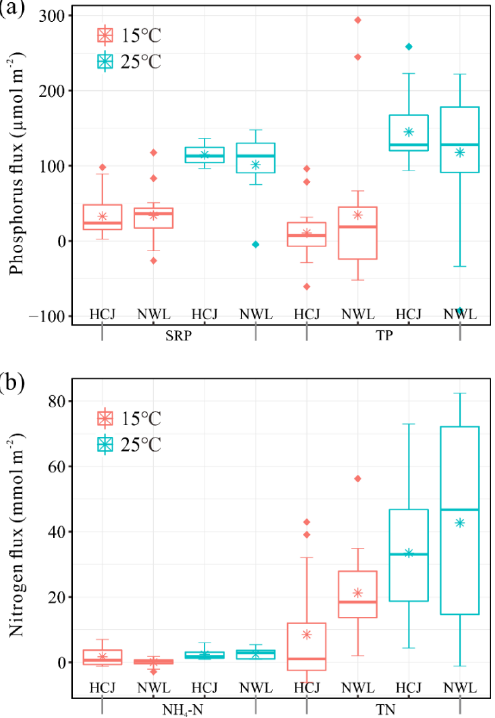
Figure 5. Boxplots of apparent fluxes of ( a ) soluble reactive P (SRP) and dissolved total P (TP) and ( b ) ammonium (NH 4 -N) and total N (TN) during the 20-day incubation at 15 °C and 25 °C from sediments from Hongchaojiang (HCJ) and Niuweiling (NWL) reservoirs. The middle bar represents the median, while the asterisk in the box represents the mean of all sediment from two sites in NWL and HCJ. The lower and upper bars limit the 1st quartile (q0.25) and the 3rd quartile (q0.75), respec- tively. The lower and upper whiskers are, respectively, the 1st quartile minus 1.5 times the inter- quartile range and the 3rd quartile plus 1.5 times the interquartile range. Diamonds outside the box represent outliers that exceed the lower and upper whiskers of the box.